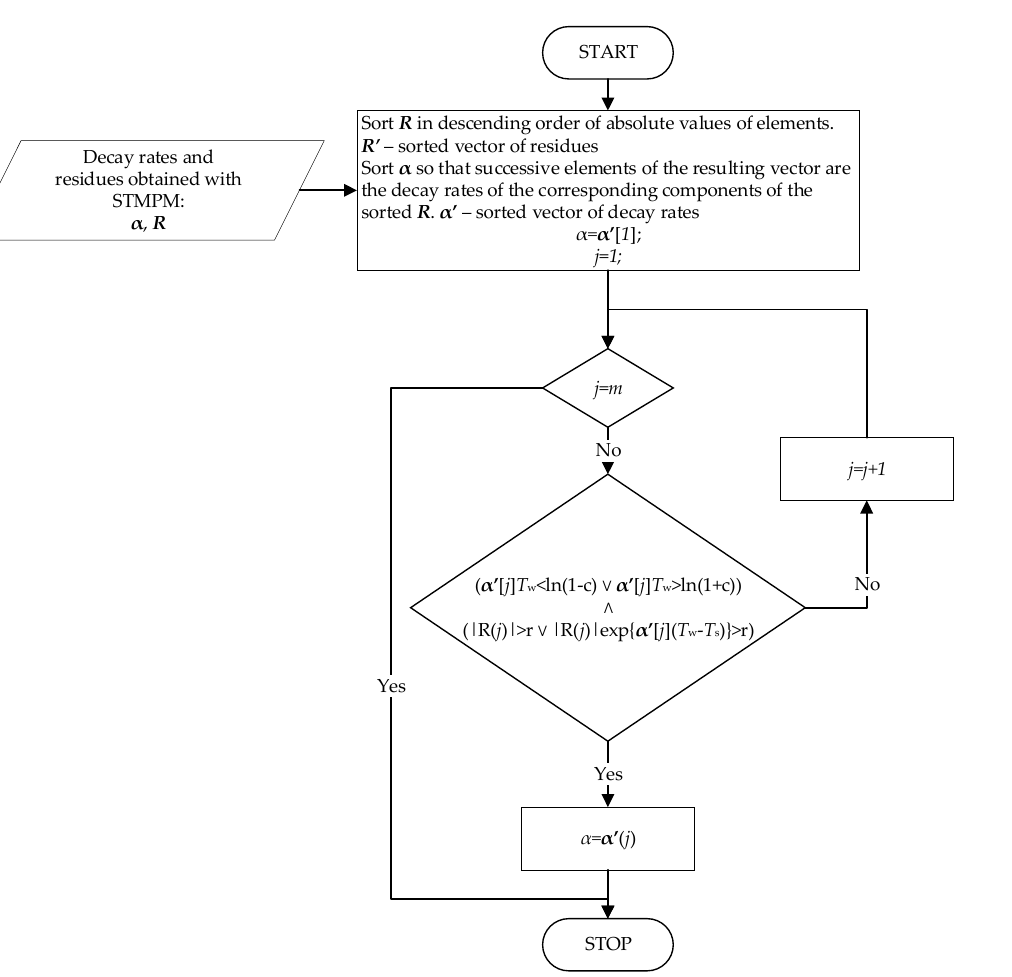
Figure 3. The algorithm of selection of decay rates.